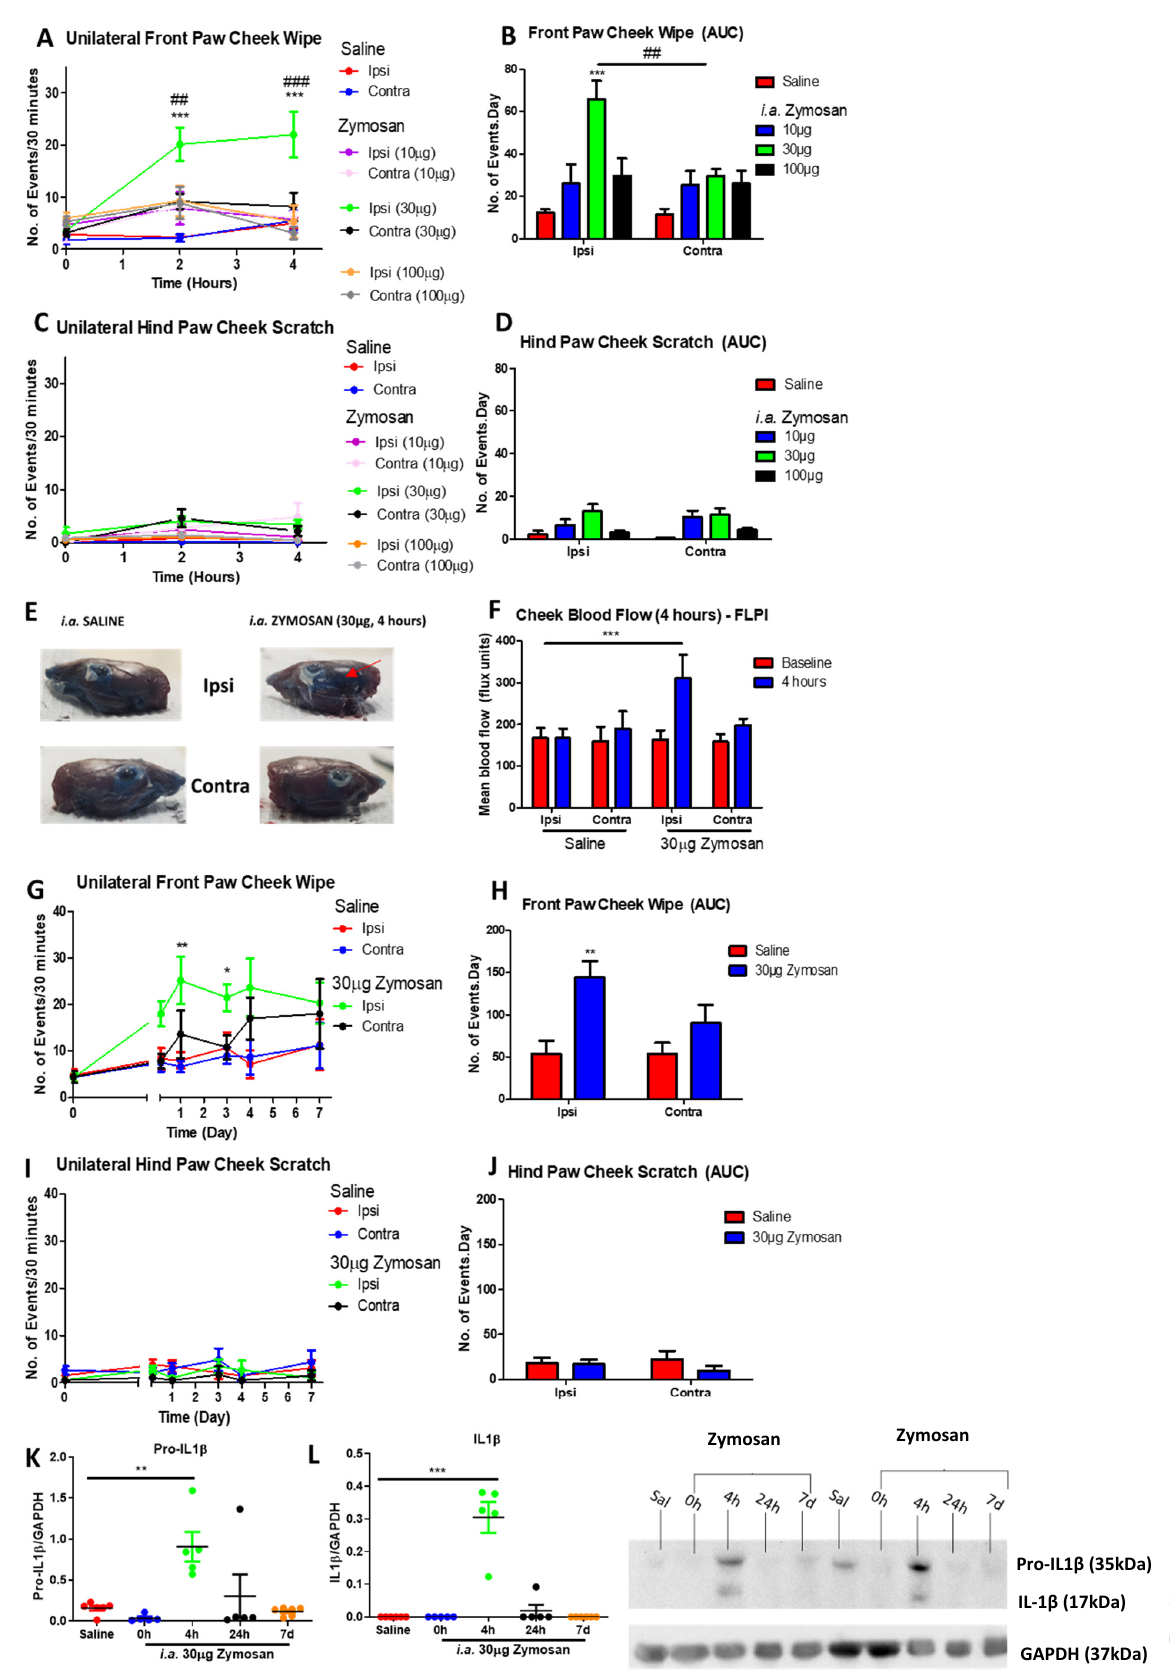
Figure 1. Intraarticular (i.a.) zymosan into the TMJ mediated increase in pain-like spontaneous behaviours and